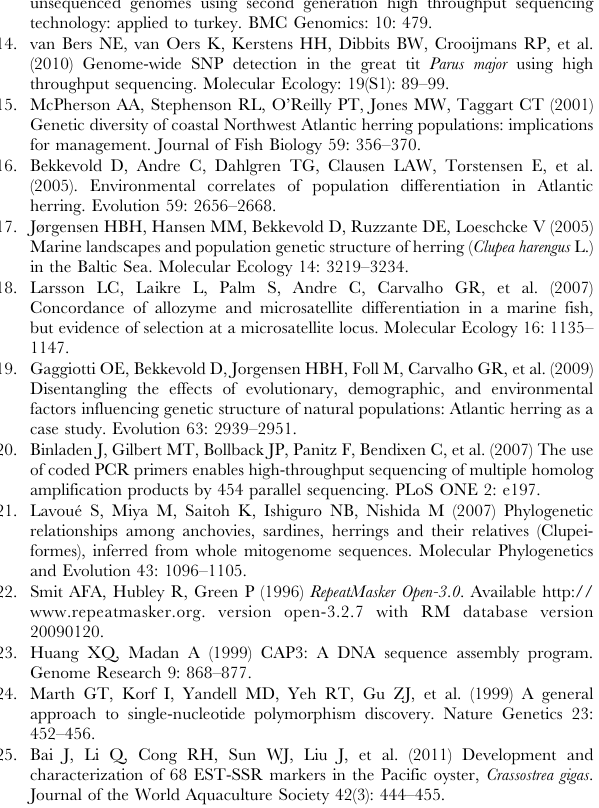
Figure S1 Analysis pipeline. The path on the left of the figure illustrates the pipeline for the genomic approach, where herring transcripts are directly compared with five reference genomes. The path on the right of the figure shows the pipeline for the transcriptomic approach, where herring transcripts are first compared to the transcriptome of the five reference species. Hits were then subsequently matched to the corresponding genomes of the same species (see text for more details). Table S1 Number of contigs and singletons annotated using a range of fish and human reference resources and databases. Table S2 List of the 578 validated polymorphic SNPs found in this study, including the 120 bp flanking region, with the two SNP